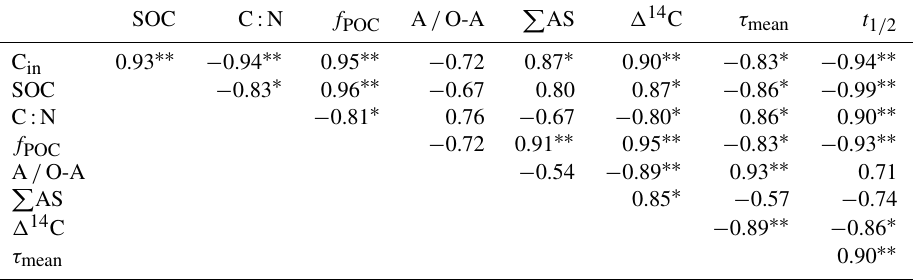
Table 6. Pearson’s correlation coefficients between mean annual C input (C in ), SOC stock, C:N ratio, fraction of SOC as POC ( f POC ), radiocarbon activity ( (cid:49) 14 C),overall turnover time (given as the average of the two modeling scenarios, τ mean ), half-life of added root exudates cocktail ( t 1 / 2 ), the alkyl / O-alkyl C ratio from NMR data (A / O-A), and the total yield of amino sugars ( P AS).